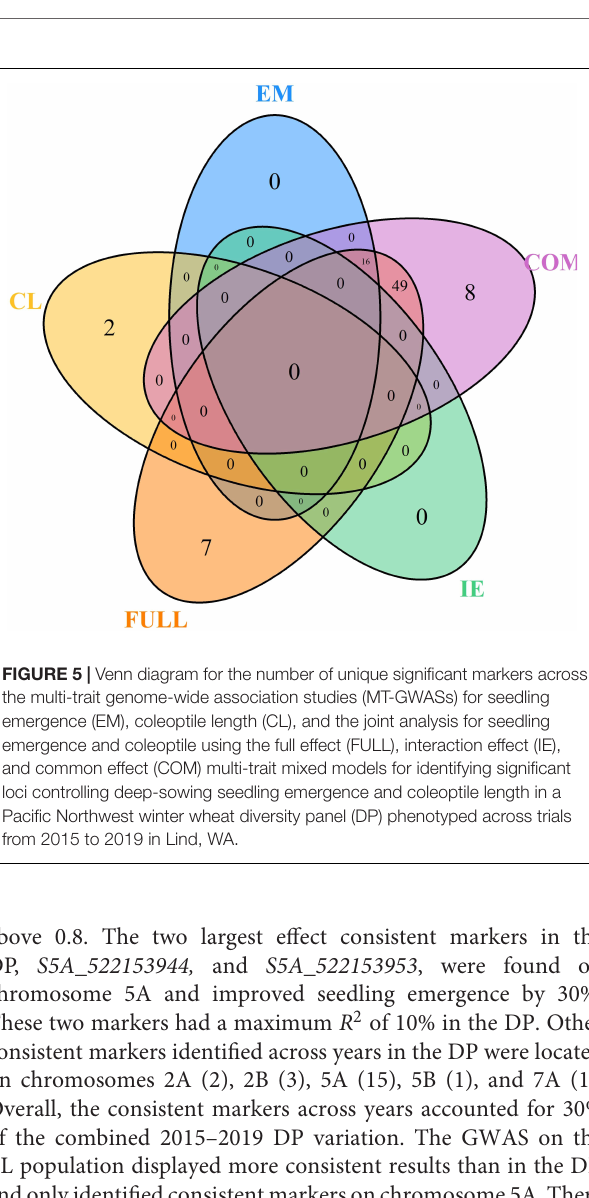
above 0.8. The two largest effect consistent markers in the DP, S5A_522153944, and S5A_522153953 , were found on chromosome 5A and improved seedling emergence by